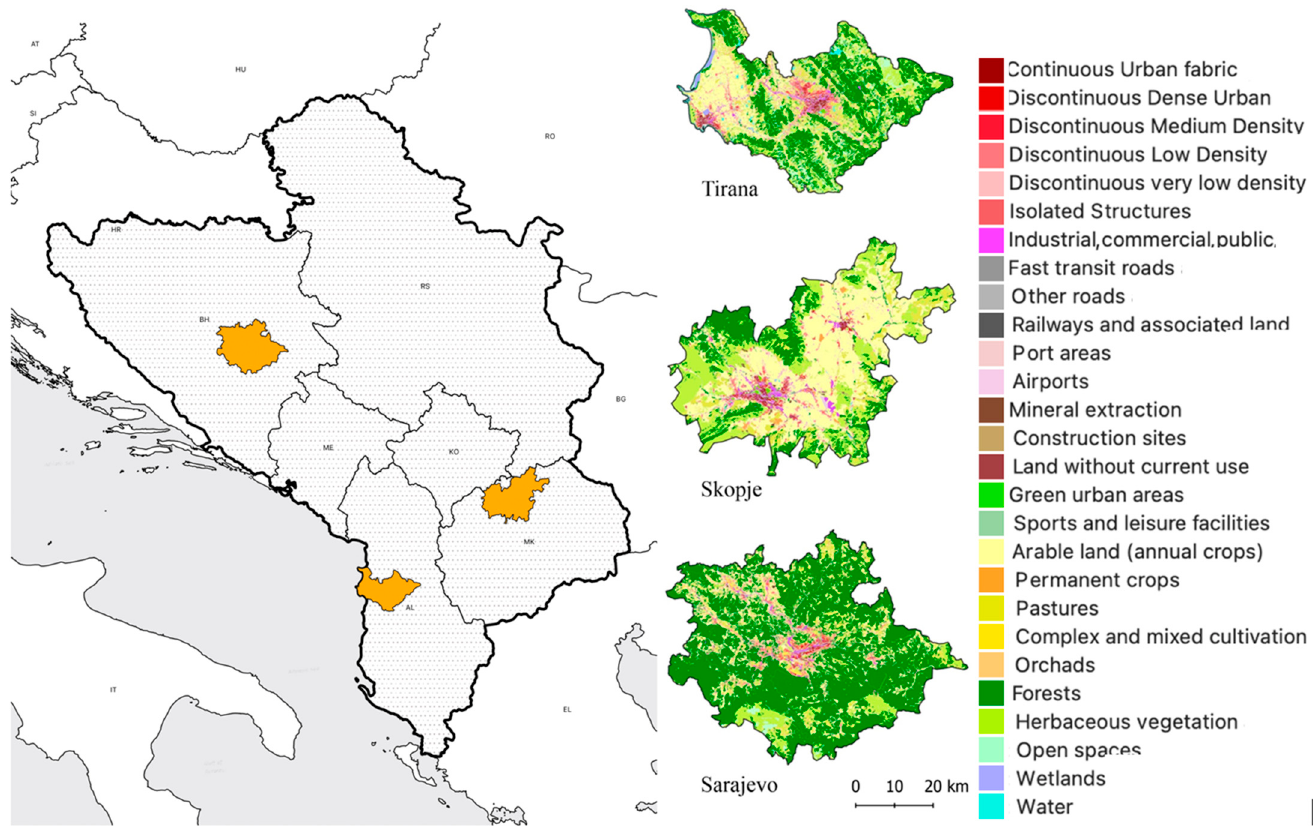
Figure 1. Metropolitan areas of Tirana, Skopje, and Sarajevo including the respective LULC (based on Urban Atlas data of 2018).